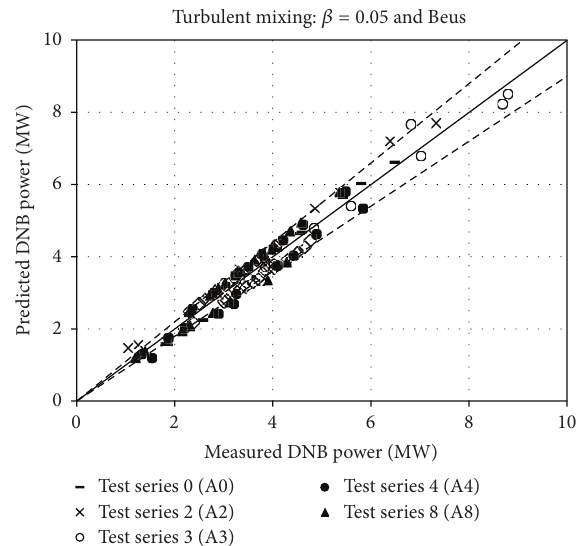
F 9: Predicted versus measured DNB with turbulent mixing and void dri modeling (single-phase mixing coefficient of 0.05 and two-phase mixing by